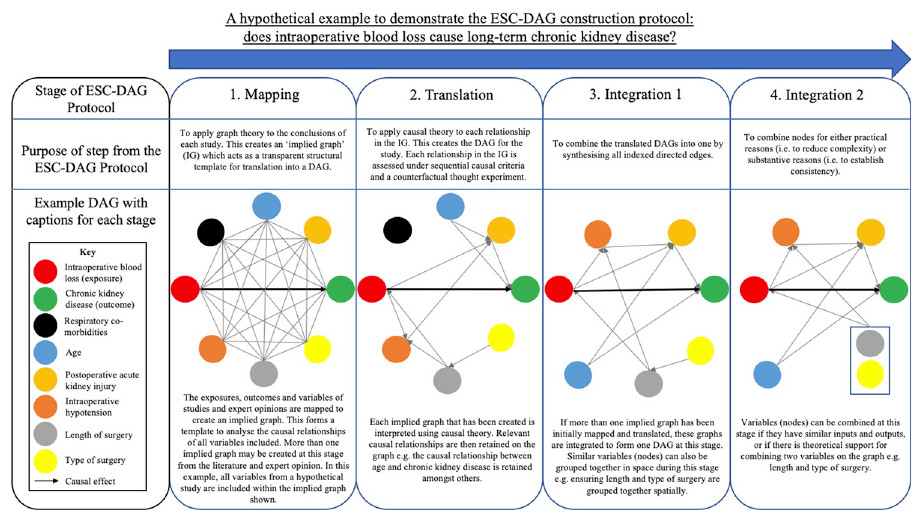
Fig 2. An outline of the stages of the ESC-DAG protocol [11], including an example construction of a perioperative DAG.